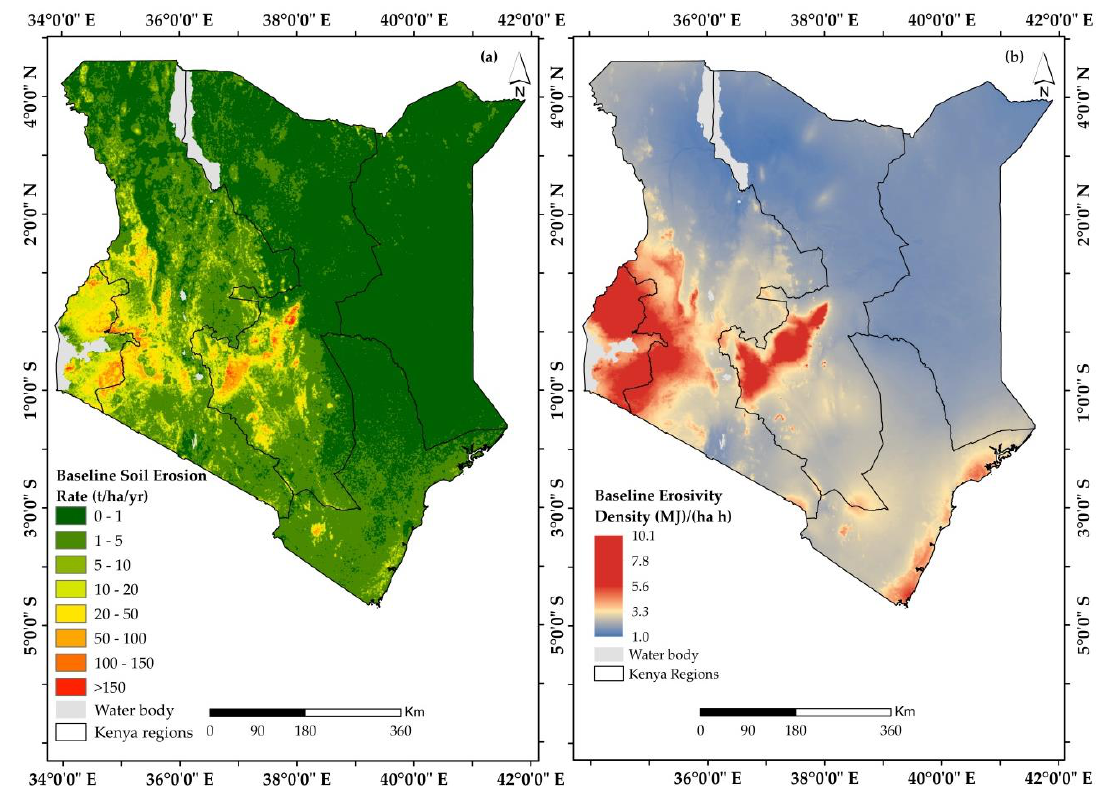
Figure 9. ( a ) Spatial distribution of the mean baseline annual soil erosion rate; ( b ) Baseline erosivity density distribution.